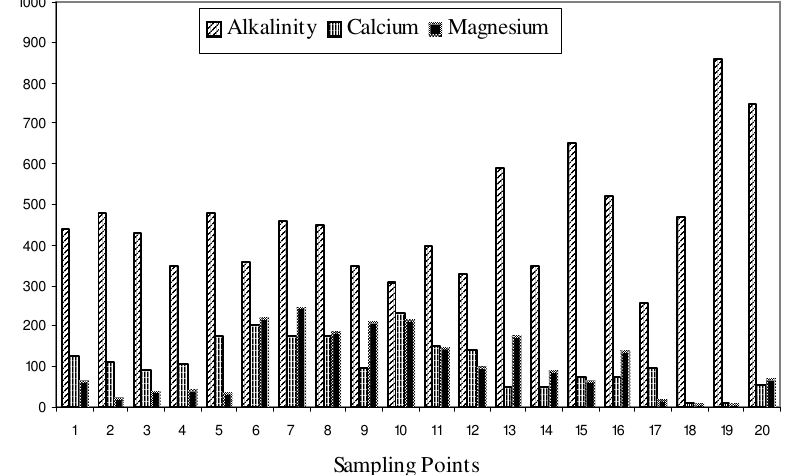
Figure 2. Alkalinity and Hardness of various groundwater samples collected from